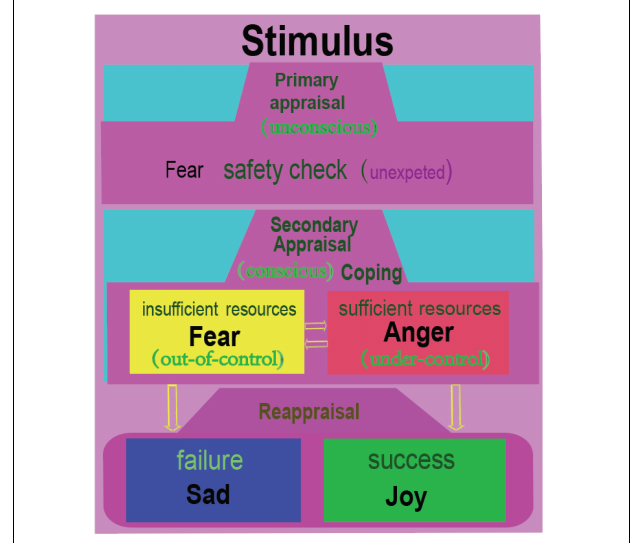
FIGURE 4 | Fear and anger are twin emotions. At a surprise or uncertain situation, we humans usually have a safety check with the situation, which is unconscious, similar to Lazarus’s primary appraisal. Then the individual will consciously compare the situation with his own ability to see if he can cope with the situation. If the individual feels he has insufficient resources, he would flight away; or he will be angry and fight. Fear and anger occur in a tandem, with fear occurring first, then anger coming immediately afterward. Afterward, the individual will reflect upon the situation, which might be called reappraisal. If he coped successfully with the situation, he will be happy; or he will be sad. Therefore, we humans have four basic emotions. Just like Izard proposed: people need the emotion fear to explain flight for safety; anger to explain tendency to cope with the unexpected situation; joy or happiness to express the pride of achievement, and sadness to express the acceptance of failure (Izard,